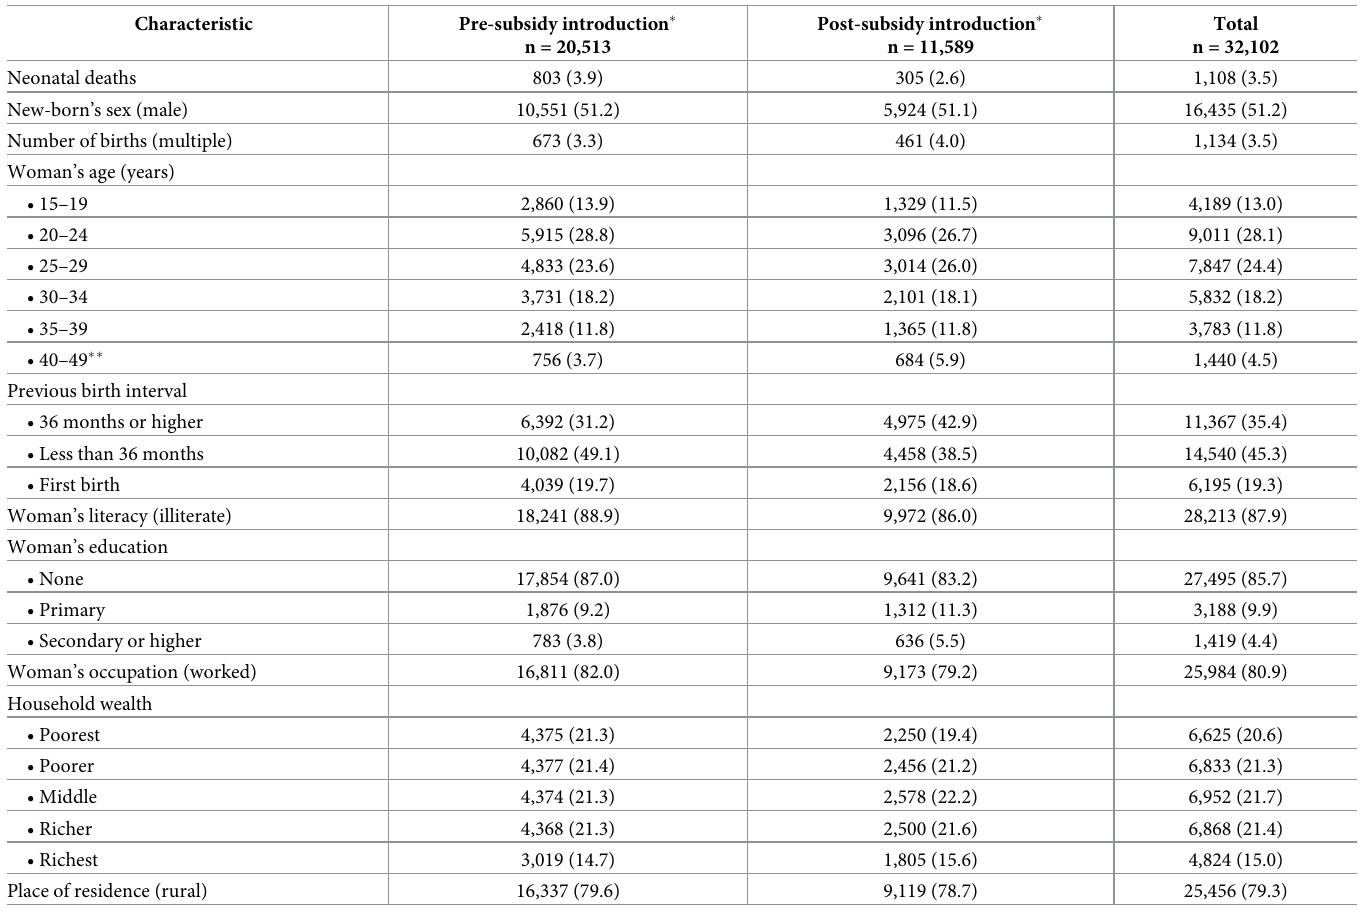
Table 1. Sociodemographic and economic characteristics of live births that occurred in Burkina Faso between January 2000 and December 2010 (Demographic and Health Survey 2010).